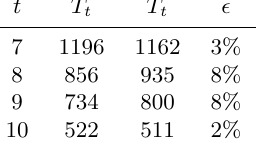
Table 6: Transaction estimates for July – October 2006 using store owner choices.